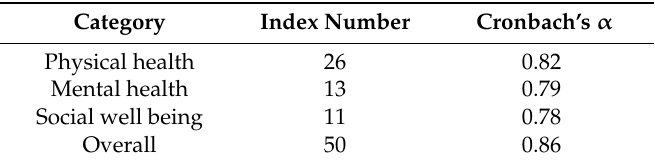
Table 5. Reliability test